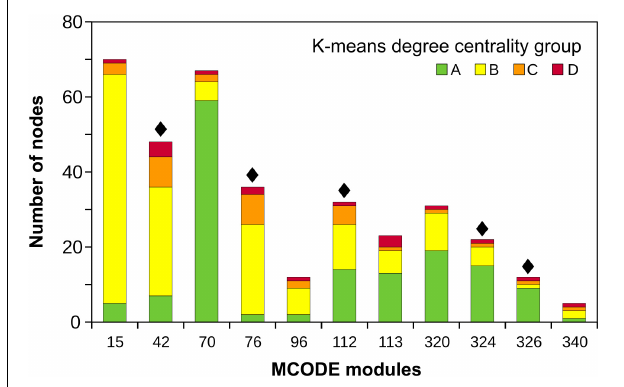
Black diamonds indicate modules harboring RGA